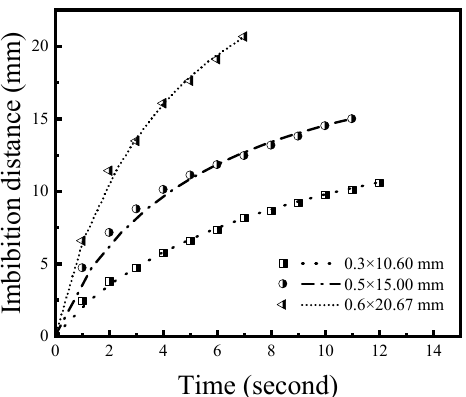
Figure 7. Comparison diagram between the fitted model curves and the corresponding experimental results (These curves represent the modified Poiseuille model curves, and the series of points represent the corresponding experimental data).